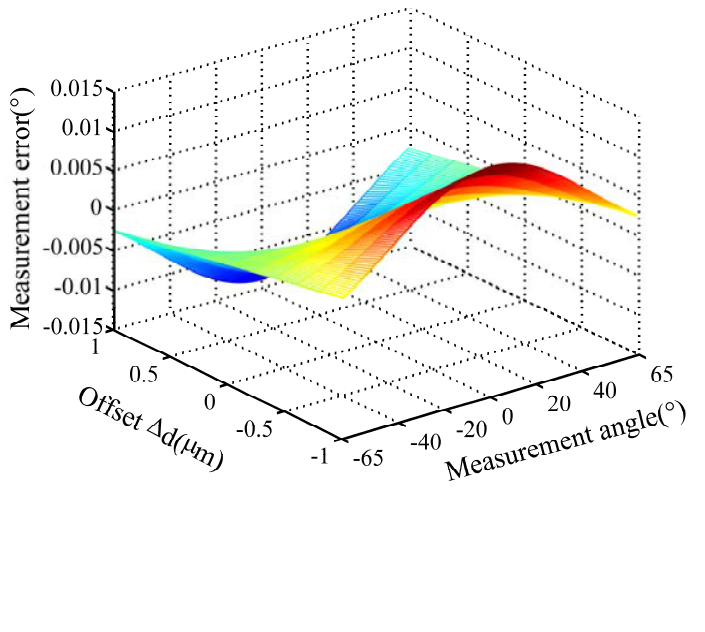
Figure 5. Measurement error caused by offset